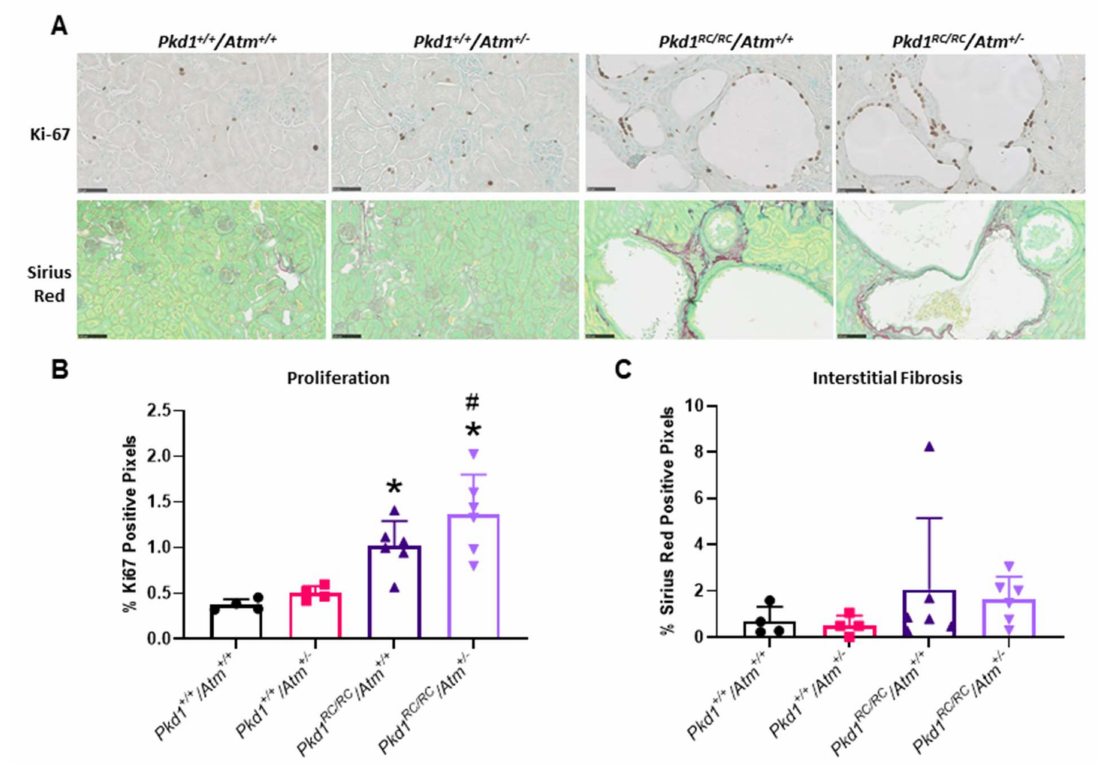
Figure 8. Effect of loss of ATM on renal fibrosis and proliferation in Pkd1 RC/RC mice at 3 months of age. ( A ) Representative histological images of Sirius Red deposition (upper panel) and Ki-67-positive staining (lower panel) in the experimental groups. Scale bars, 50 µ M. ( B ) Mean renal fibrosis score calculated by Sirius Red-positive staining. ( C ) Mean renal cell prolif- eration, as determined by quantification of Ki-67-positive staining. * p < 0.05 compared to wild-type mice ( Pkd1 +/+ /Atm +/+ ) and # p < 0.05 compared to Atm genotype matched Pkd1 +/+ . Data presented as means ± SD ( n = 4–6 per